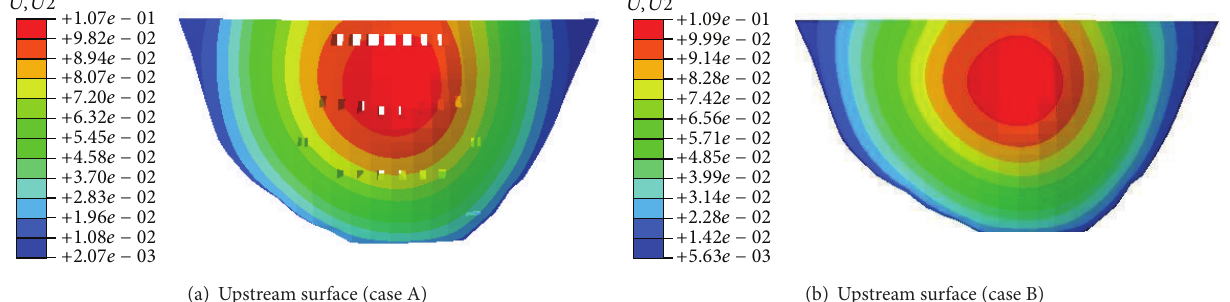
Figure 6: Displacement contour along river direction under different analysis cases (normal loads).